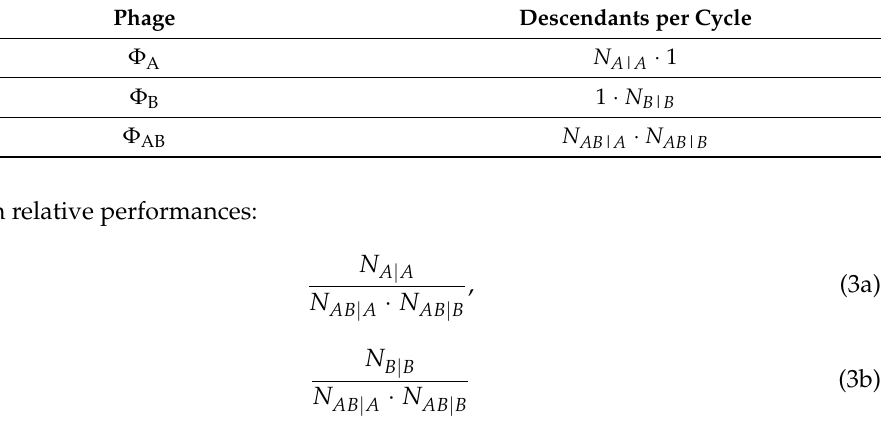
Table 4. Phage outputs during a cycle of Sequential presentation. Phage Descendants per